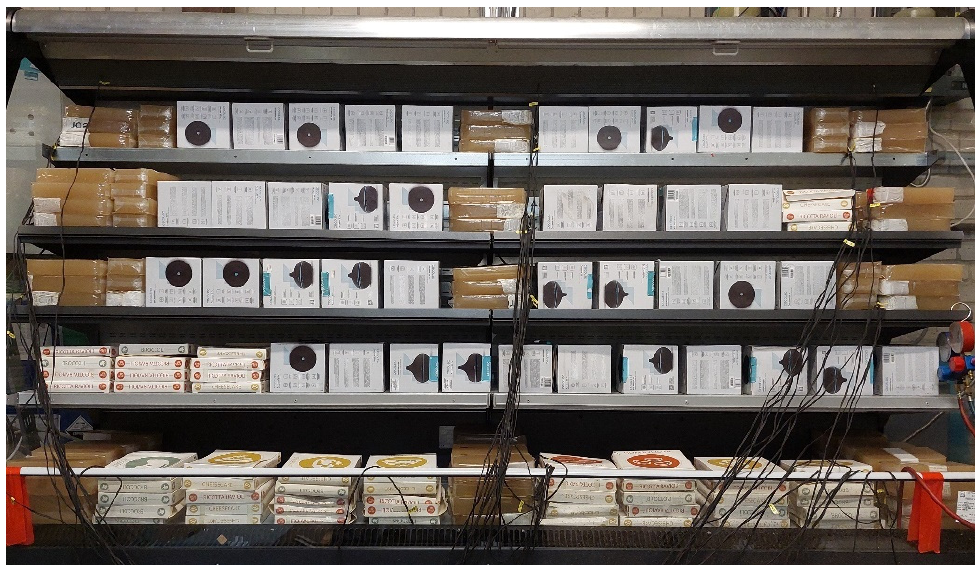
Figure 5. Refrigerated cabinet with thermocouples.